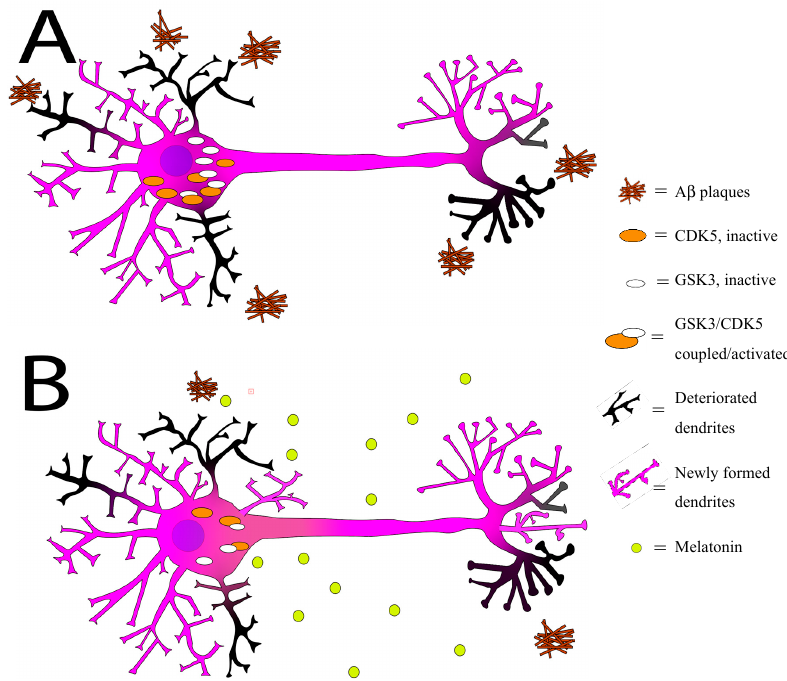
Figure 1. Melatonin regulates cycle-dependent kinase (CDK5) and glycogen synthase kinase 3 (GSK3), promotes dendritic growth of neurons, and flushes out A β plaques. ( A ) Neuron exhibits an excess of CDK-5 (